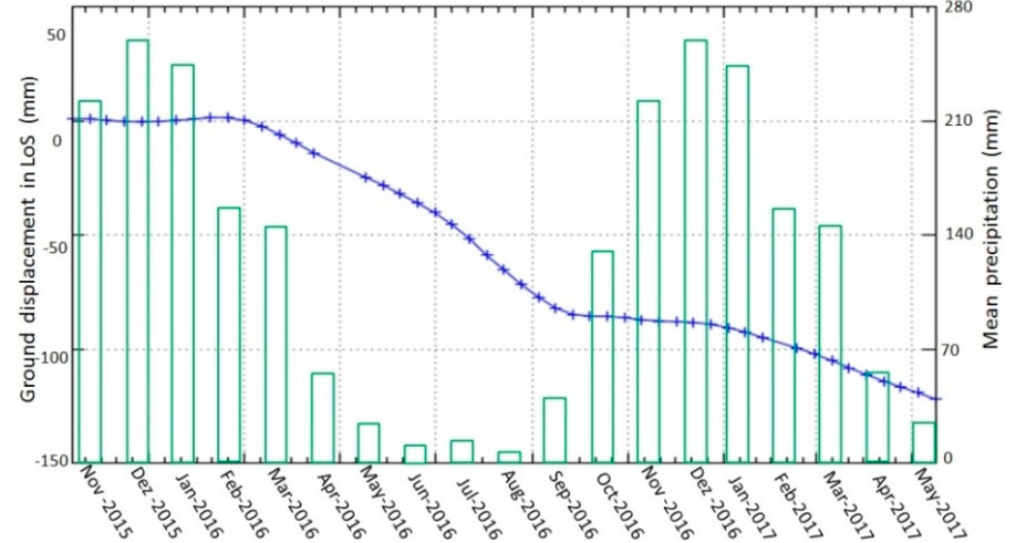
Figure 23. PSI results of the ground displacement in LoS of the point P4 in the reservoir of Baía 3 versus the mean precipitation during the period of November 2015 up to May 2017.